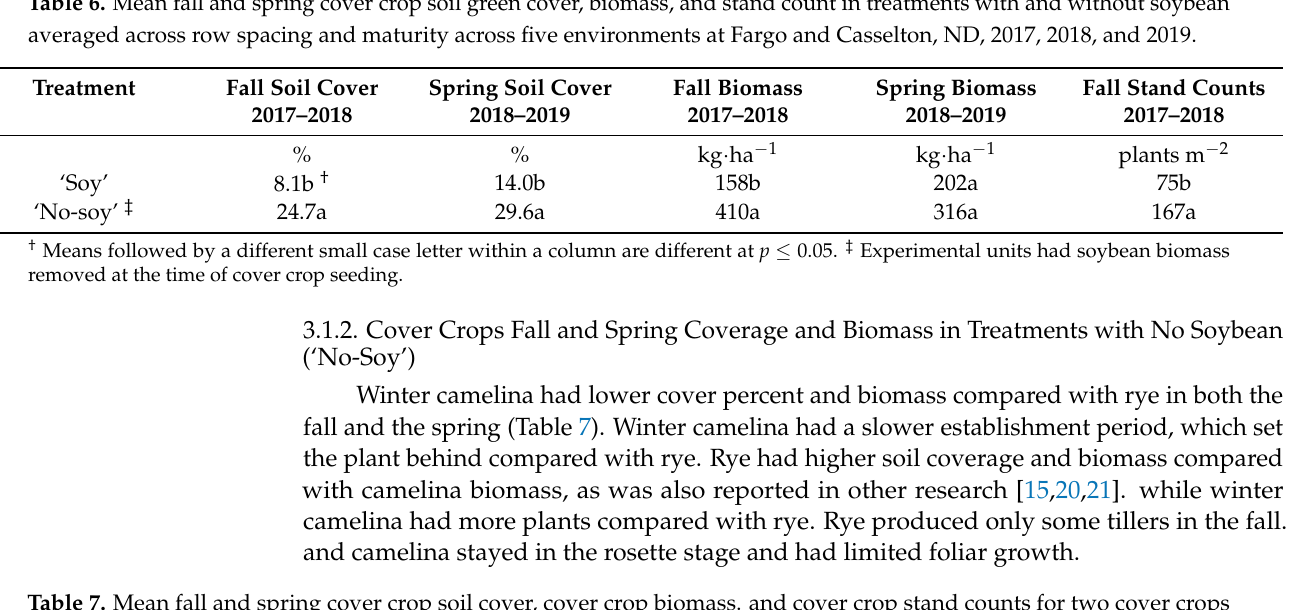
Table 6. Mean fall and spring cover crop soil green cover, biomass, and stand count in treatments with and without soybean averaged across row spacing and maturity across five environments at Fargo and Casselton, ND, 2017, 2018, and 2019. Treatment